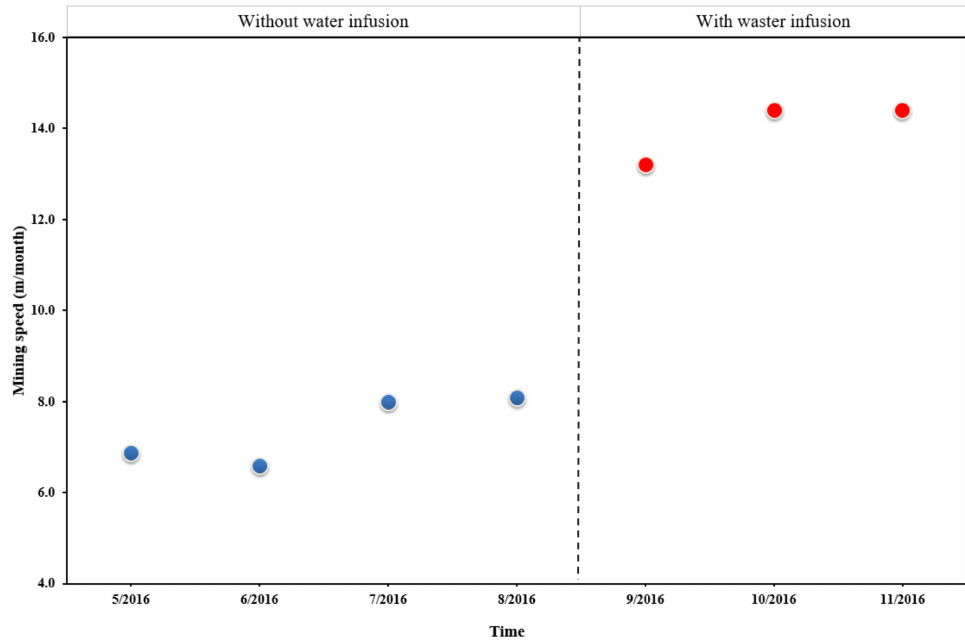
Figure 11. Mining speed of the coal seam with and without using water infusion.